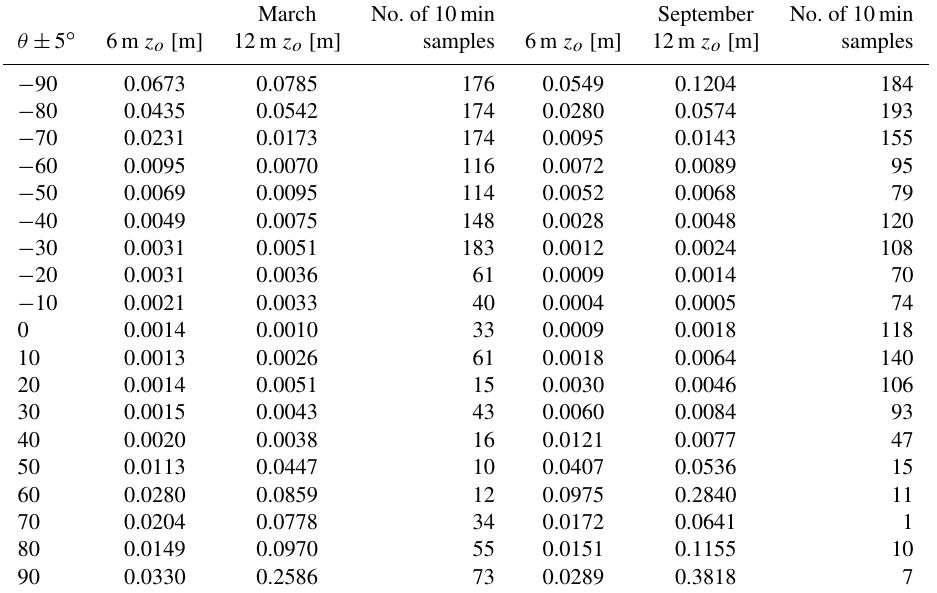
Table 3. Roughness length z o as function of the relative wind direction θ based on either the 6 or the 12m sonic anemometer for both March and September 2015. The amount of 10min samples is also shown.